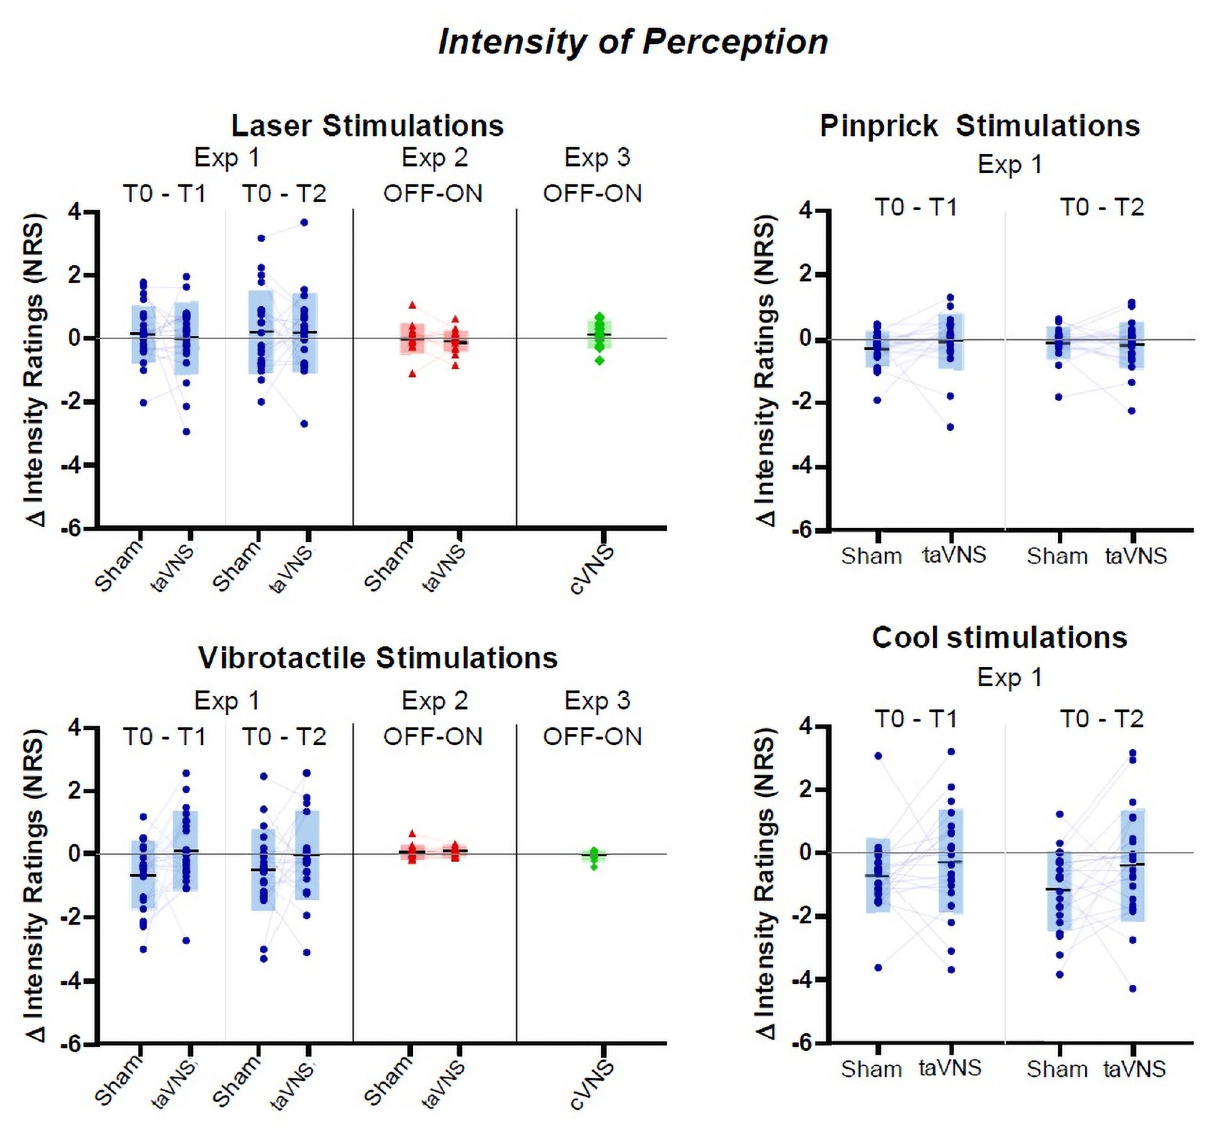
Fig 4. Behavioral responses: Intensity of perception. Each diagram represents the perceived intensity for one specific somatosensory modality, under different conditions (sham, taVNS or cVNS). Within each diagram, individual values are shape-coded according to the experiment in which they were retrieved (circles for Experiment 1, triangles for Experiment 2, diamonds for Experiment 3), with values from a same individual linked by a grey line. Grey boxes represent group statistics, with the central horizontal lines and top/bottom extremities indicating the means ± SD values. The Y axes represent the differences in intensity ratings between T0 vs. T1, T0 vs. T2 or OFF vs. ON phases. Intensity ratings were collected using a numerical rating scale (NRS) from 0 (no sensation) to 10 (maximal sensation). The X axes indicate which timepoints or phases of the duty cycle are compared on the related Y axes. There was no significant alterations